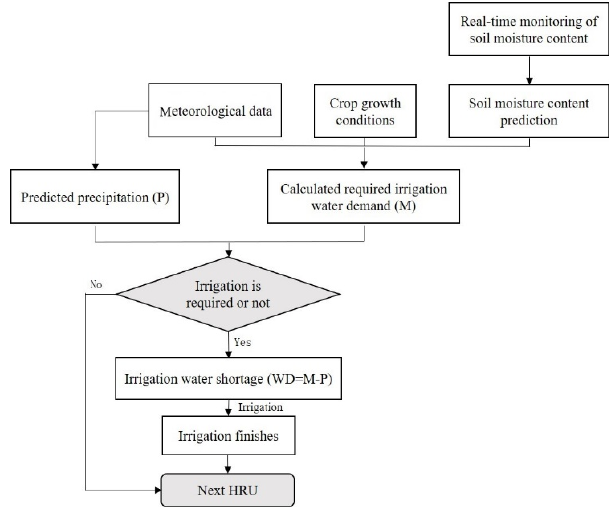
Figure 2. Structure of the real-time irrigation module.